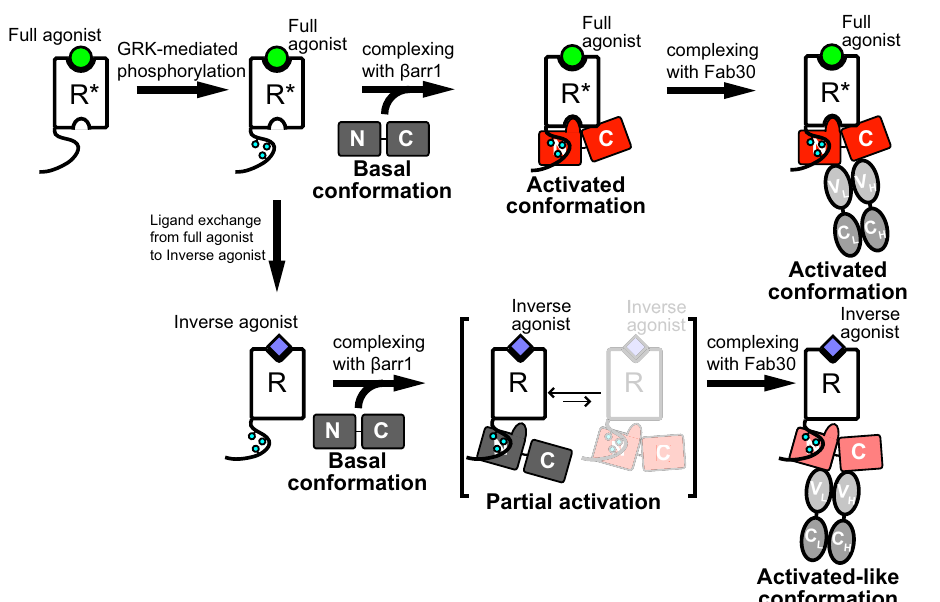
Fig. 5 Conformational activation of β arr1 upon binding to GPCRs and the synthetic antibody fragment Fab30. The full agonist-bound receptor is phosphorylated by GRK. The phosphorylated and full agonist-bound receptor interacts with β arr1 through both the TM core and C tail, and β arr1 in the complex adopts the activated conformation. Fab30 binding to the complex does not induce signi fi cant conformational changes in β arr1. In the case where the full agonist is replaced with the inverse agonist after GRK-mediated phosphorylation, the receptor only interacts with β arr1 through the C tail, resulting in partial activation in which β arr1 exists in equilibrium between the basal and activated conformations. Fab30 binding to the complex promotes β arr1 to adopt the activated-like conformation, which is partly similar to the activated